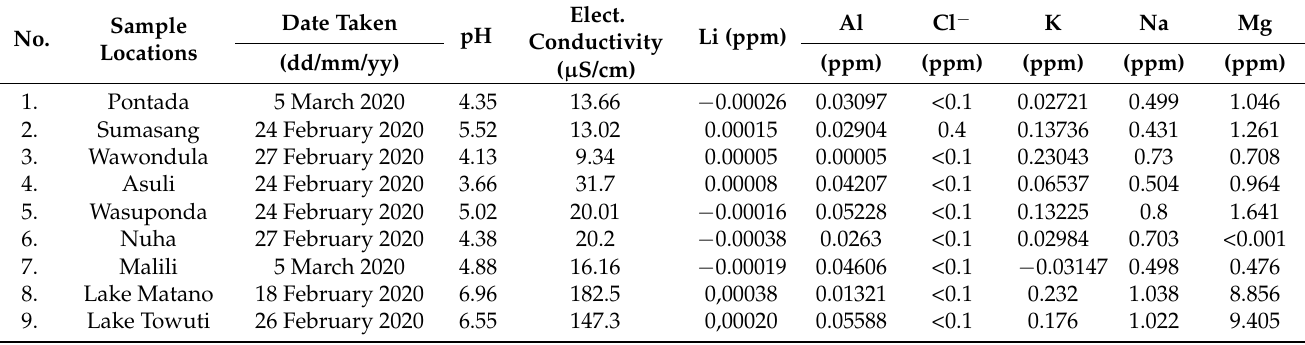
Table A2. The Larona basin’s water quality characterizations results, which consist of physical and chemical characterizations. The physical characterization was performed by measuring the water’s electrical conductivity (in µ S/cm), while the chemical characterizations were performed by measuring the water’s Li, Al, Cl − , K, Na, and Mg content (in ppm) and its